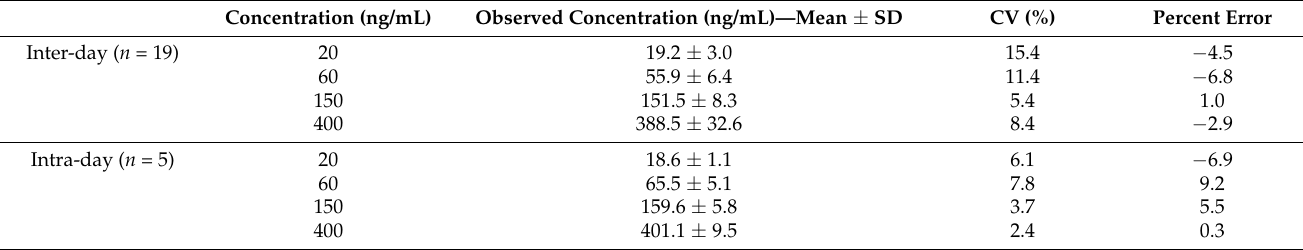
Table 1. Inter- and intra-day accuracy (%error) and precision (%CV) for clobazam (CLB). Concentration (ng/mL)